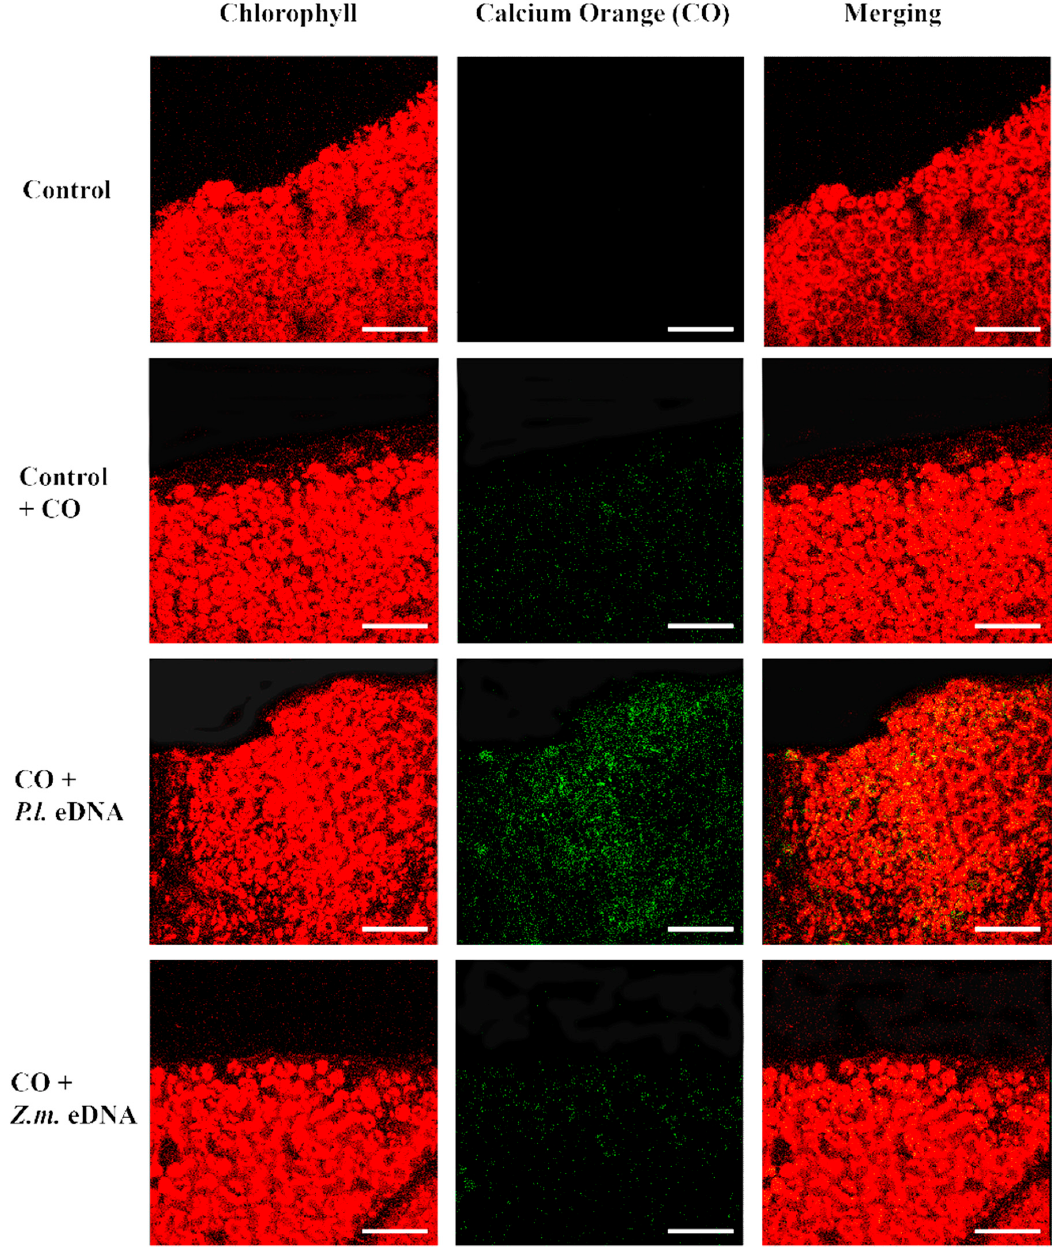
Figure 4. Intracellular calcium variations in Lima bean leaves upon different treatments. False-color image analysis reconstructions from confocal laser-scanning microscope observations, and fluorochemical intracellular Ca 2+ localization. Fifty microliters of 200 µg·mL − 1 of either esDNA or extracellular heterologous DNA (etDNA) were applied, and after 30 min the calcium signature was observed. Pictures represent portions of the Lima bean leaf blade where the green fluorescence refers to binding of calcium orange with Ca 2+ , whereas the chloroplasts are evidenced by a bright red color caused by chlorophyll fluorescence. Scale bar (100 µm) is indicated on the figures. CO, calcium orange; P.l. , Phaseolus lunatus ; Z.m ., Zea mays .